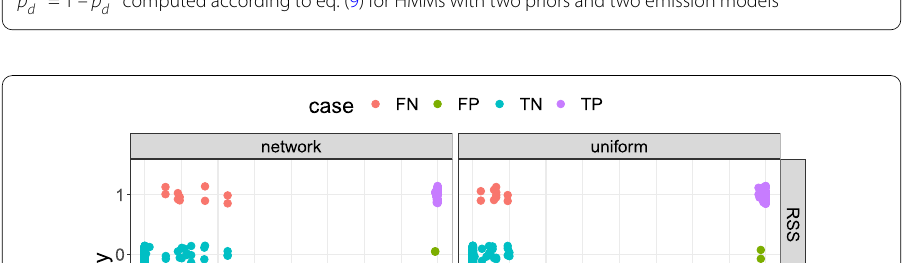
. ROC curves for the duplicity probabilities d